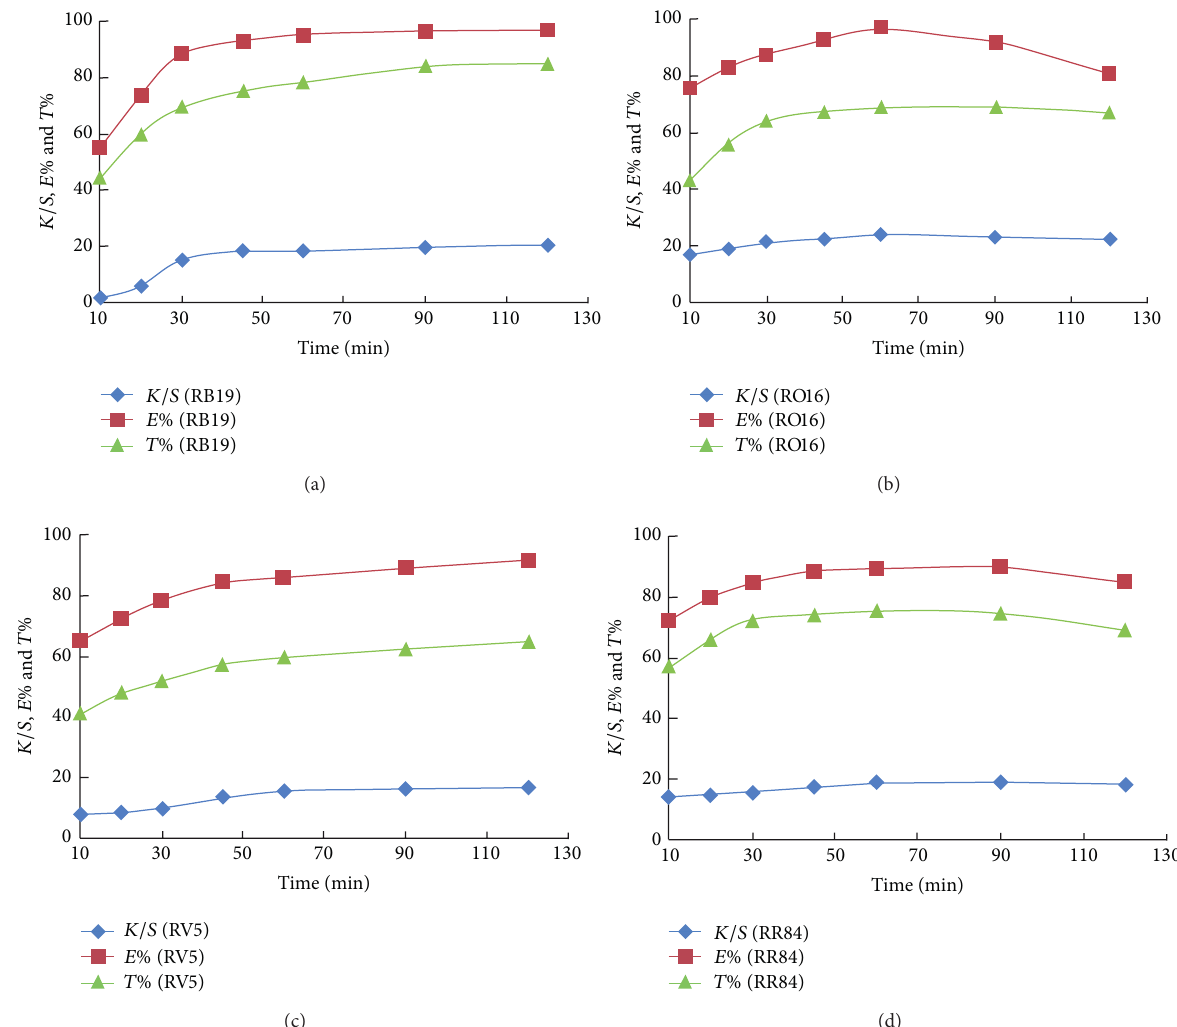
Figure 5: Colour strength, exhaustion, and total fixation of amidoximated acrylic fabrics using nucleophilic addition type reactive dyes of different structures as a function of time; dyeing conditions: shade 2% owf, liquor ratio 40 :1, pH 2.5, at 100 ∘